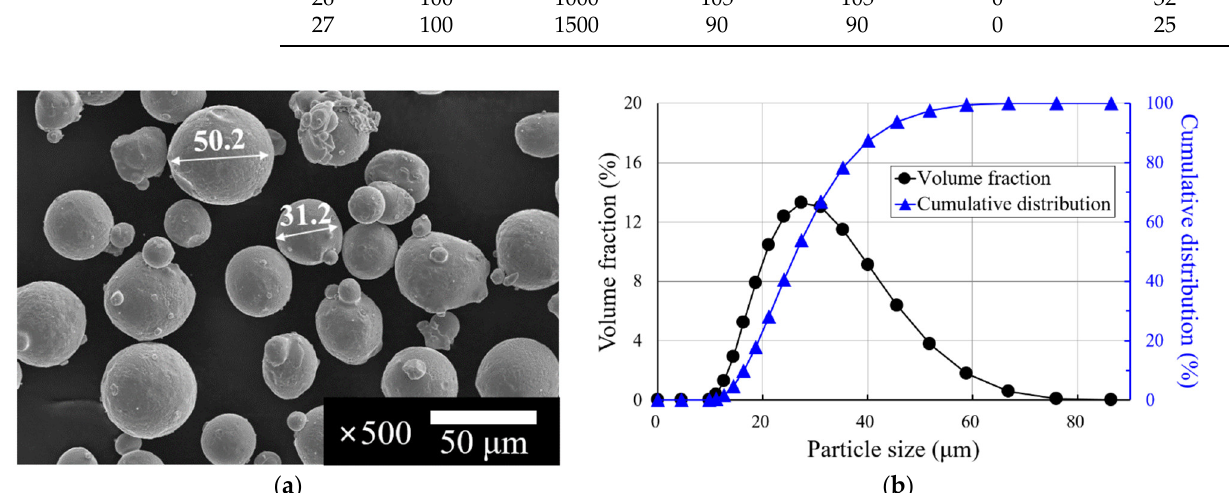
Figure 5. Shape and size distribution of ASTM 316L powder: ( a ) shape of ASTM 316L powder and ( b ) volume fraction and cumulative distribution of ASTM 316L powder. Table 2. Chemical composition of deposition and substrate material (Wt.%).